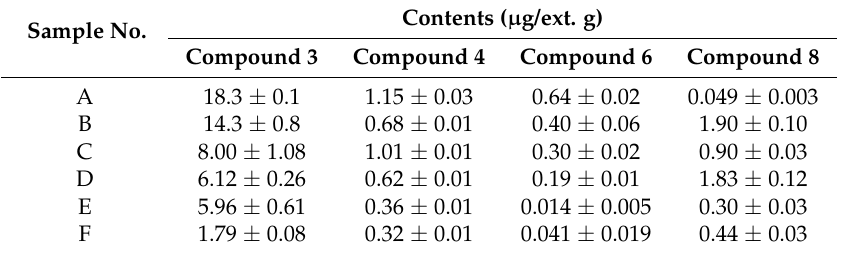
Table 4. Contents of the four major compounds in SCS extract samples ( µ g/ext. g). Sample No.